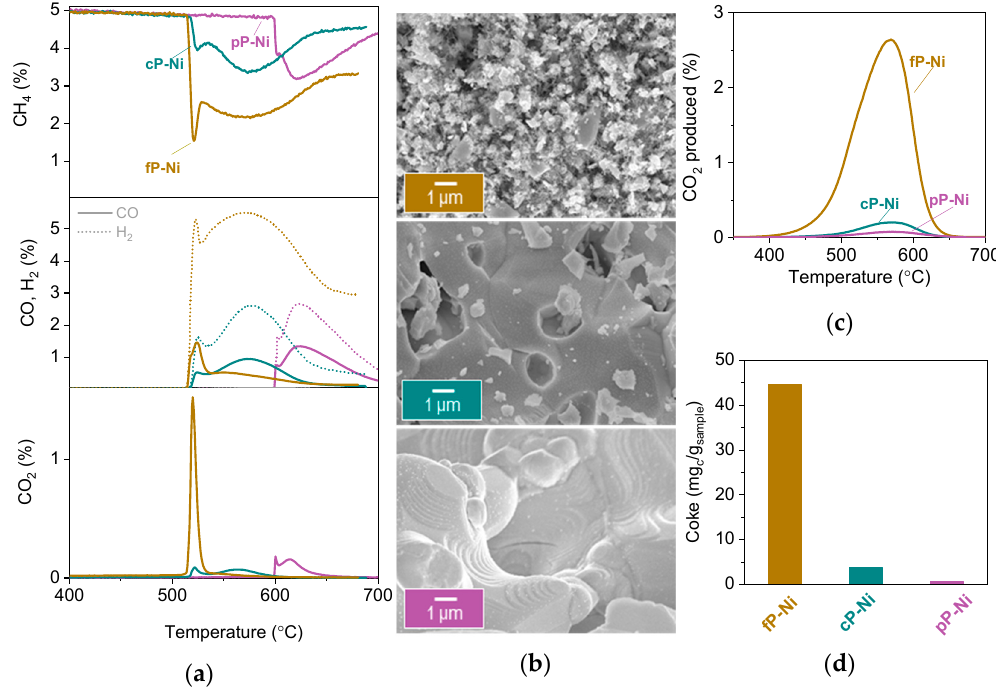
Figure 5. Activity of the exsolved perovskites with different microstructures. ( a ) Methane conversion to CO, CO 2 and H 2 observed for all the samples. ( b ) Microstructure (SEM) analysis of the samples after experiment described in (a). ( c ) CO 2 produced during oxidation of the samples after MTPR testing in (a) and ( d) the calculated coke for the experiment described in (c).